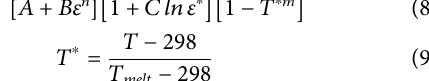
Frontiers in Materials |